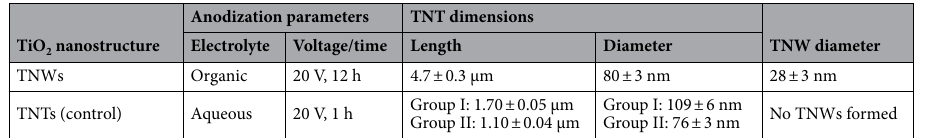
Table 2. Morphology of TiO 2 nanostructures obtained after anodization using different parameters.